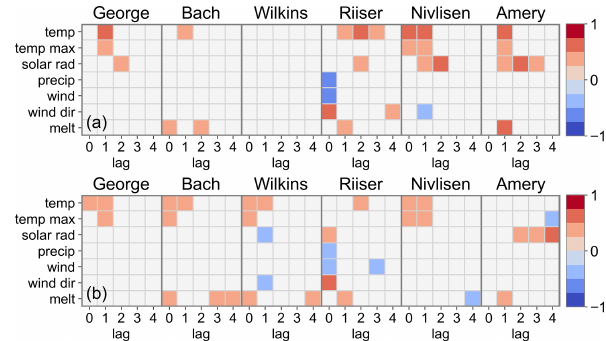
Figure 6. (a) Results of the statistical correlation analysis between spatially averaged fractional lake extents and climate variables air temperature (temp), maximum air temperature (temp max), solar radiation (solar rad), precipitation (precip), wind magnitude (wind), wind direction (wind dir) and snowmelt (melt) at time lags 0–4 over George VI, Bach, Wilkins, Riiser-Larsen, Nivlisen and Amery ice shelves. (b) Results of the statistical correlation analysis between anomalies of spatial averages of fractional lake extents and anoma- lies of climate variables. The correlation coefficient is given in the interval [ − 1, + 1] and is illustrated for significant correlations with p < 0 . 05 only. Correlations with p > 0 . 05 are masked. More de- tail on the individual correlation values can be found in Tables S1 and